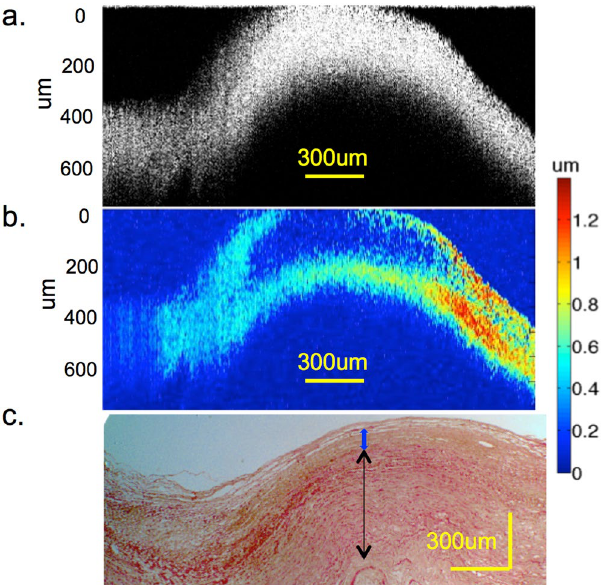
Figure 5. Cadaver tissue & histology data. ( a ) OCT image of human cadaver coronary artery cross-section. ( b ) OCE elastogram of corresponding region. (c ) H&E staining of the region under 4x magnification. Red box corresponds to region of stiff